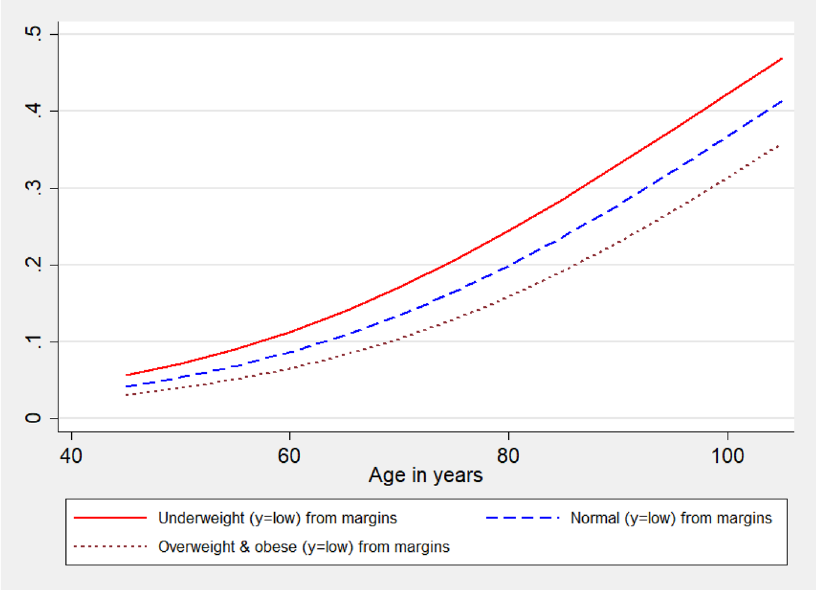
Figure 2. Average marginal effects of age on low cognition by body mass index (BMI) among older adults, LASI, Wave 1, 2017–2018.